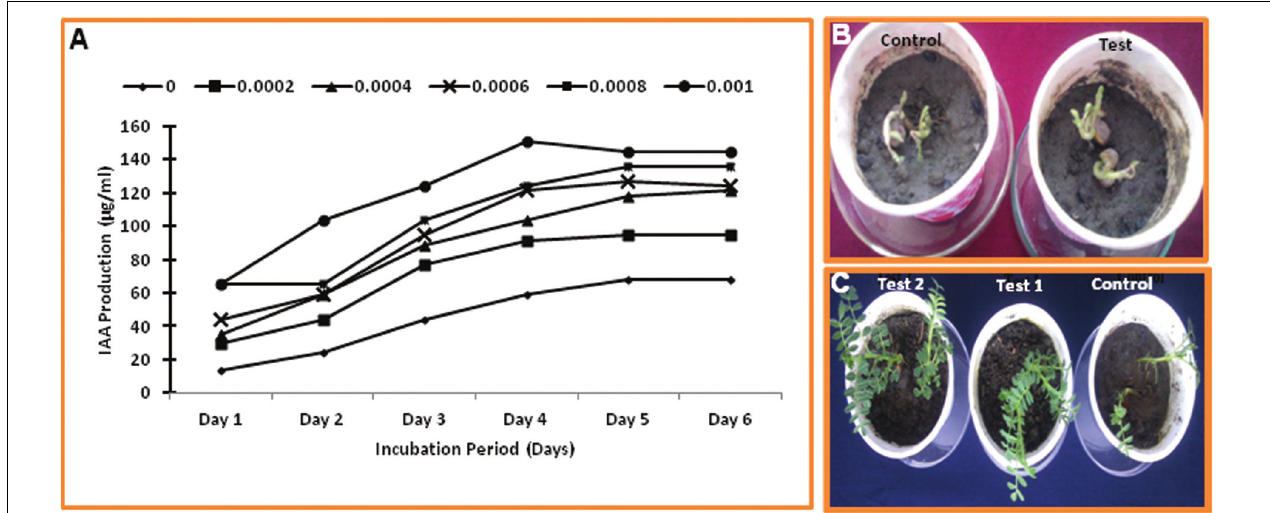
FIGURE 7 | Plant growth promoting activity of feather hydrolysate from keratinase production media. (A) Indole-3-acetic acid (IAA) production in culture media supplemented with different concentrations of L - tryptophan during incubation of 6 days; (B) Effect of feather hydrolysate supplementation in soil on seed germination; (C) Effect of feather hydrolysate supplementation in soil on plant